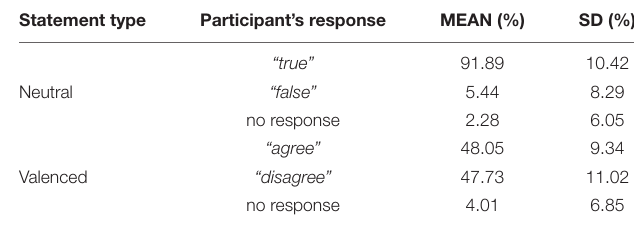
TABLE 1 | Percentages of different response types to neutral and controversial